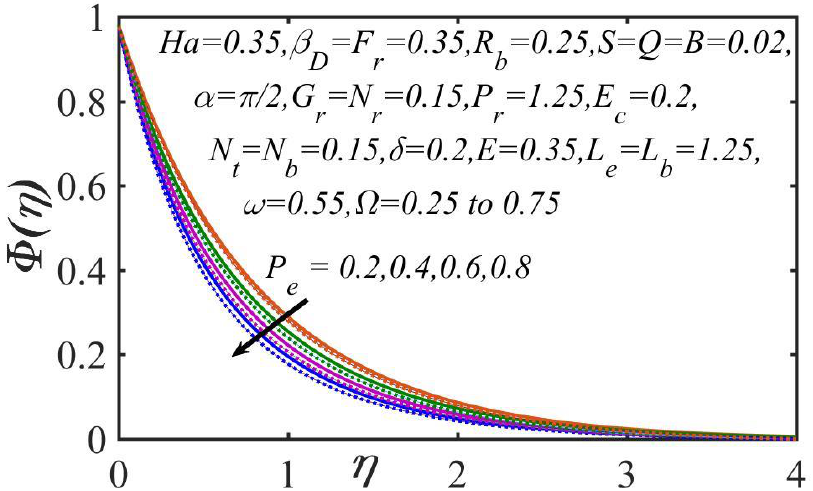
Figure 15. Impact of 𝑃 𝑒 and Ω on the microorganisms ’ magnitudes. Solid curve: Ω = 0.25 ; dotted curve: Ω = 0.75 .